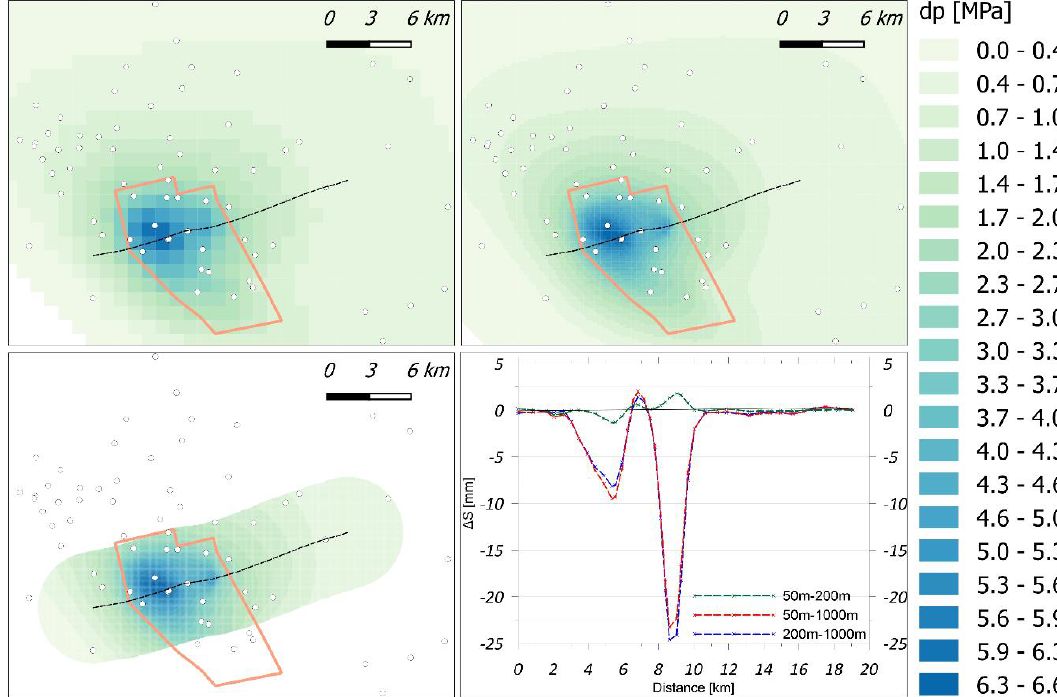
Figure 6. Division of aquifer into cuboid reservoir elements whose bases measured 1000 m, 200 m, and 50 m. Owing to the large number of base elements measuring 50 m, a buffer was used for profile A-A. Changes in reservoir element pressure are shown in the color scale.